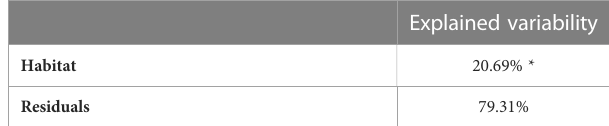
TABLE 1 PERMANOVA